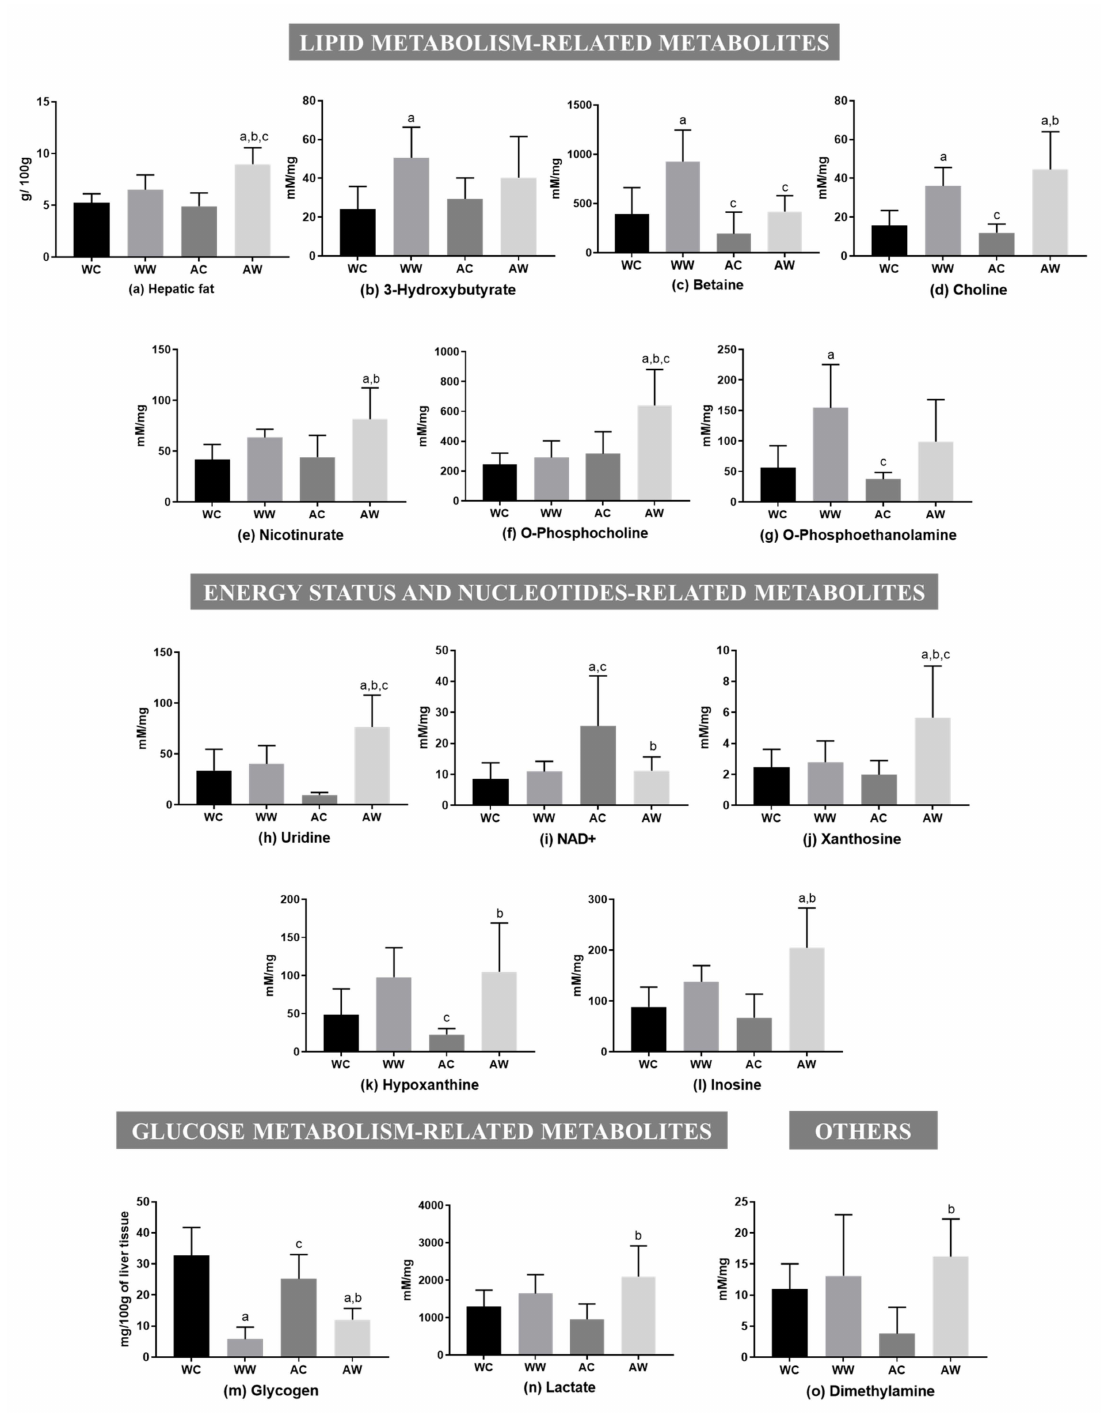
Figure 2. Liver metabolites in weanling and adult control and tumour-bearing animals. Lipid metabolism-related metabolites: ( a ) hepatic fat; ( b ) 3-hydroxybutyrate; ( c ) betaine; ( d ) choline; ( e ) nicotinurate; ( f ) O-phosphocholine; ( g ) O- phosphoethanolamine. Energy status and nucleotide-related metabolites: ( h ) uridine; ( i ) NAD+; ( j ) xanthosine; ( k ) hypox- anthine ( l ) inosine. Glucose metabolism-related metabolites: ( m ) glycogen; ( n ) lactate. Others: ( o ) dimethylamine. Legend: WC, weanling control group ( n = 7); WW, weanling tumour-bearing group ( n = 10); AC, adult control group ( n = 6); AW, adult tumour-bearing group ( n = 8). Data were expressed as mean ± standard deviation (SD), millimolar/milligram of liver tissue or mg/100 g of liver tissue for glycogen content. Data were analysed by two-way ANOVA and corrected for multiple comparisons by the post hoc test Bonferroni. a represents differences from the WC group, b indicates differences from AC group and c indicates differences from the WW group. Differences were significant when p <